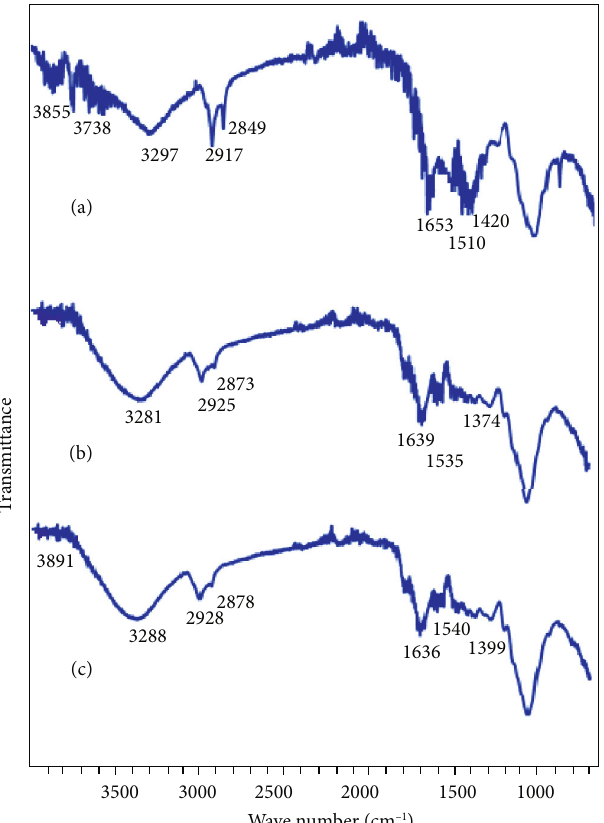
Figure 3: FTIR spectra of (a) Brassica oleracea (BO), (b) Congo red loaded Brassica oleracea (BO-CR), and (c) brilliant green loaded Brassica oleracea